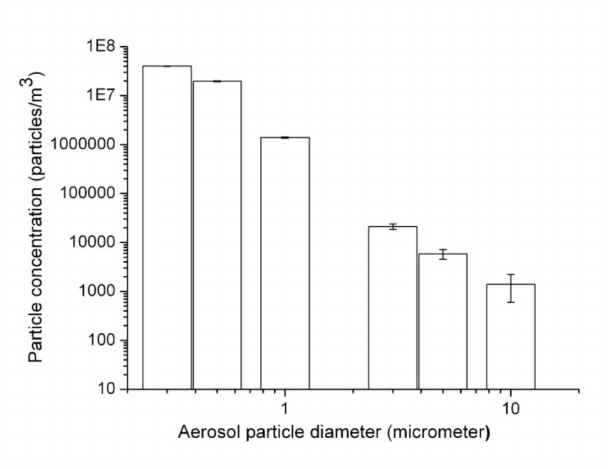
Figure 2. Aerosol particle size distributions in the experimental air environments (without LN 2